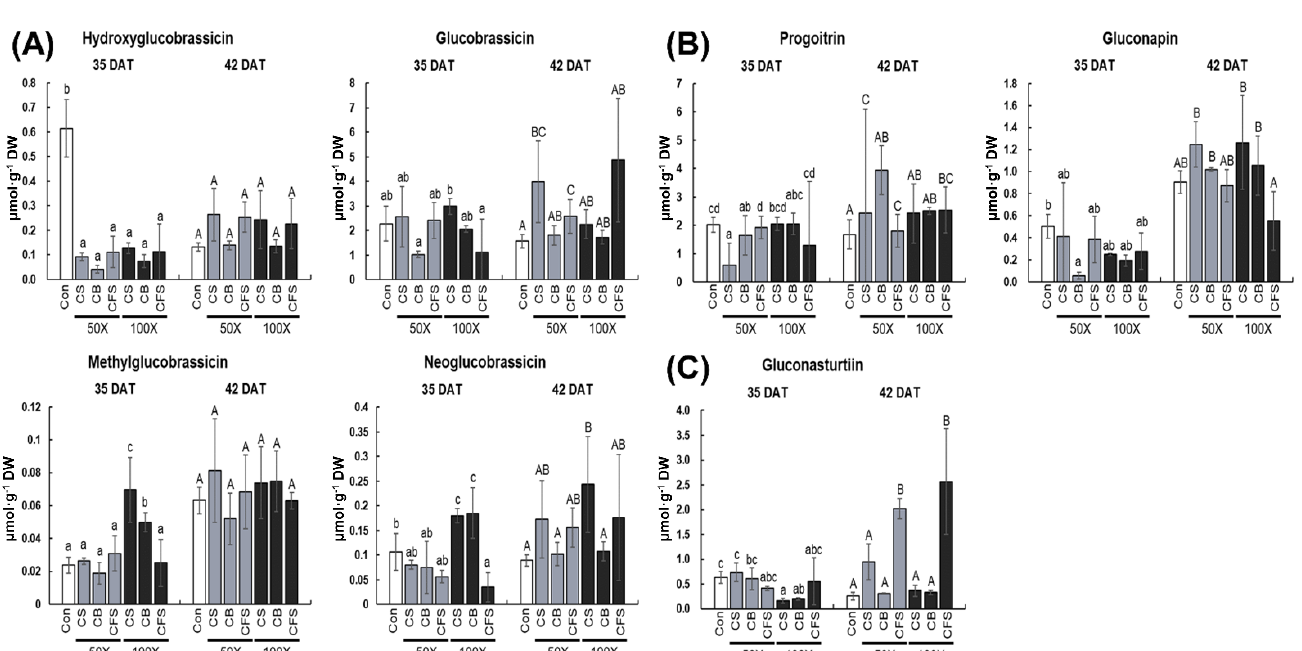
Figure 7. Representative HPLC chromatogram from 50× CFS-treated kale monitored at 520 nm. Peak 1, cyanidin 3-(feruloyl)-diglucoside-5-glucoside; 2, cyanidin 3-(sinapoly)( p -coumaroyl)-diglucoside- 5-glucoside; 3, cyanidin 3-(sinapolyl)(sinapoyl)-diglucoside-5-glucoside; and 4, cyanidin 3-(sin- apoyl)-triglucoside-5-glucoside. Table 4. Anthocyanins identified in “Red Russian” kale. No RT 1